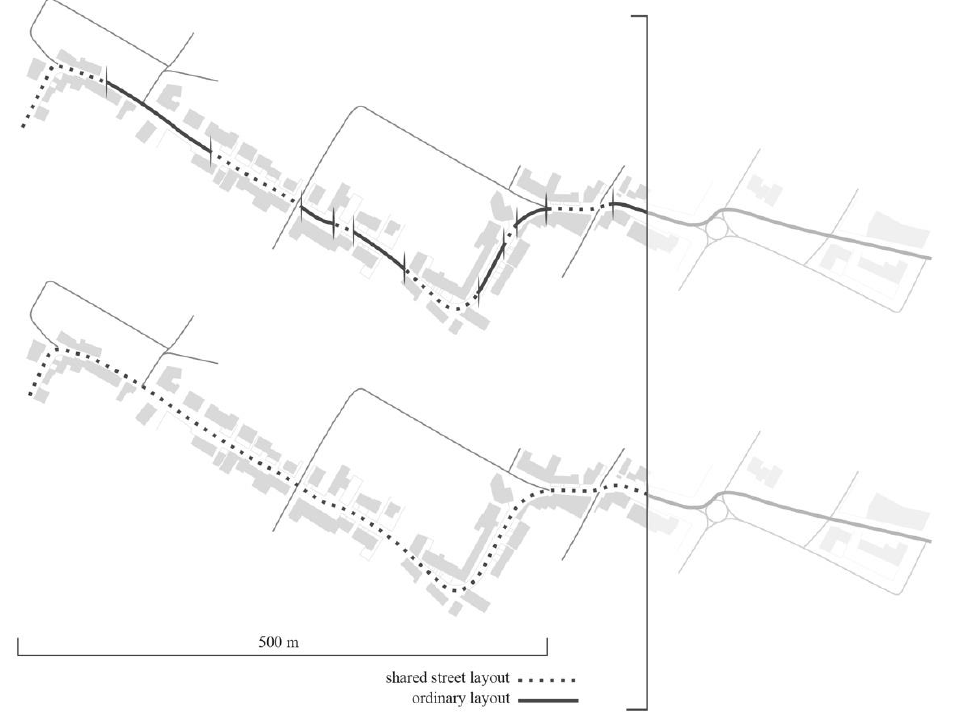
Figure 5. A diagram of the two options of the street partial or total